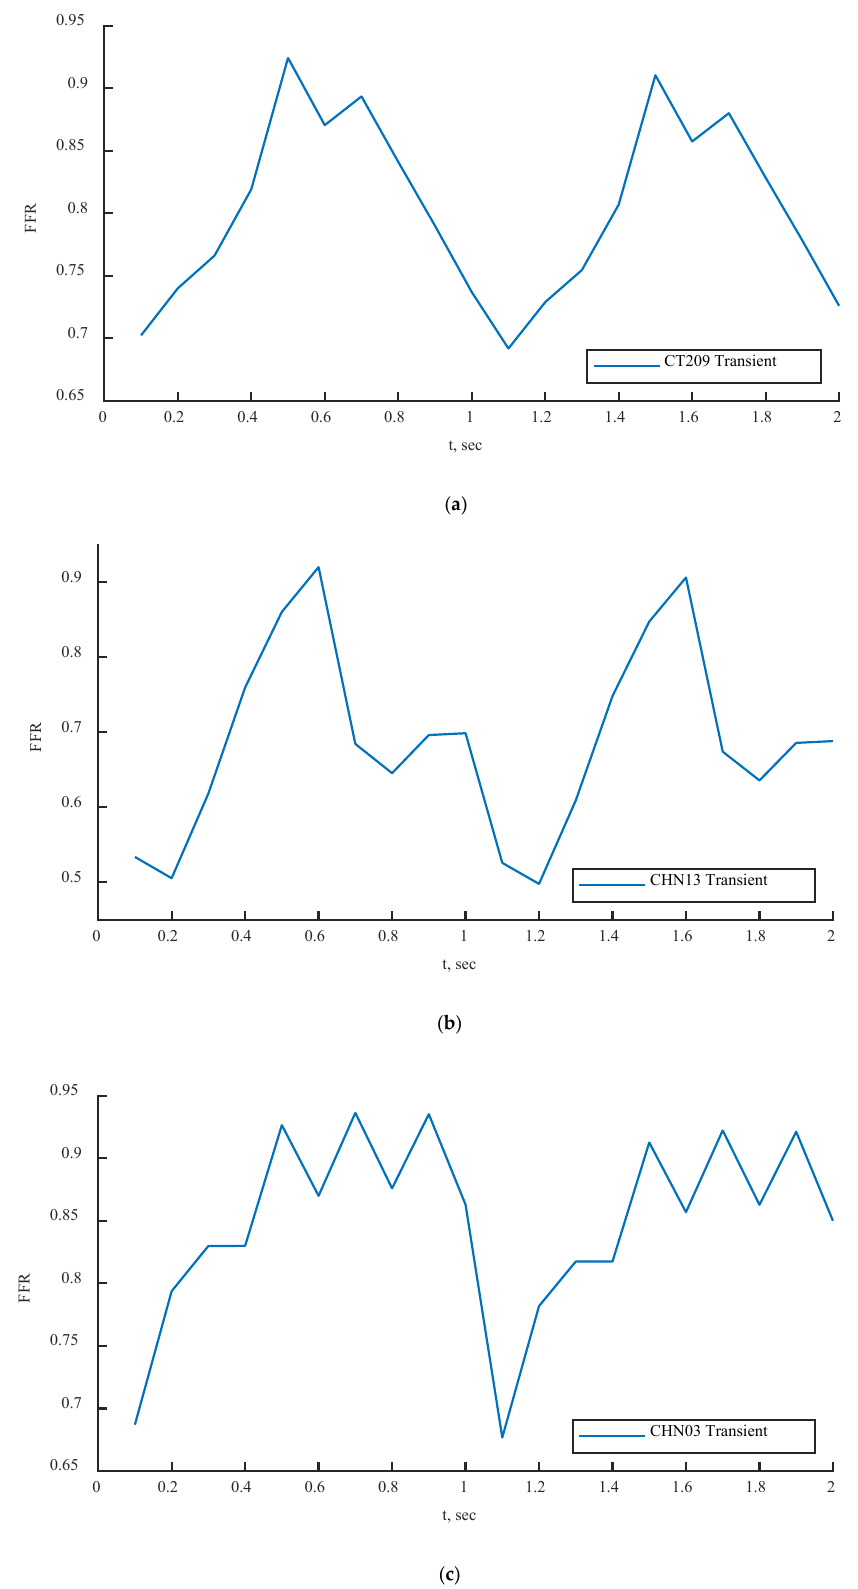
Figure 21. ( a ) FFR probe value comparison between steady-state and transient PBA models for ( a ) CT209, ( b ) CHN13, and ( c ) CHN03 .